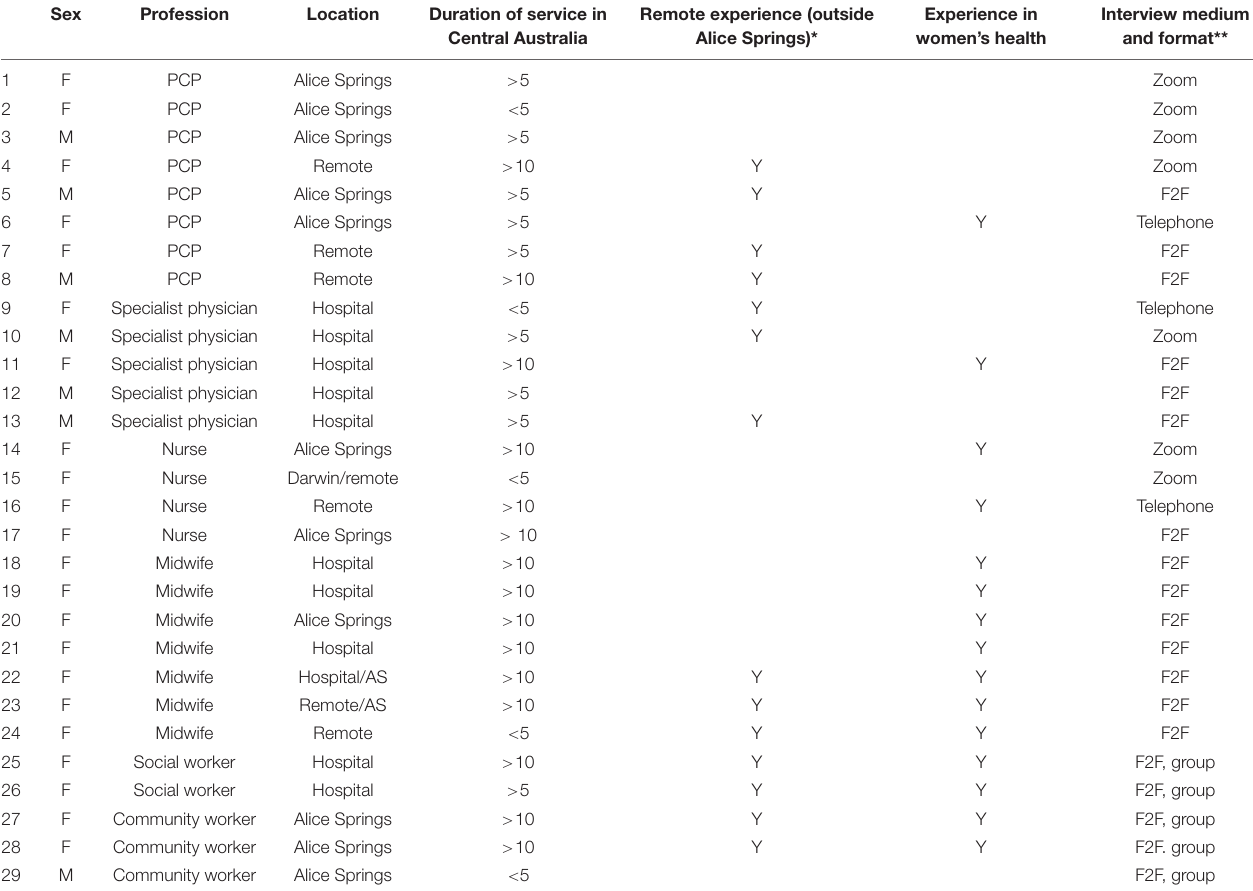
TABLE 2 | Profile of non-Aboriginal